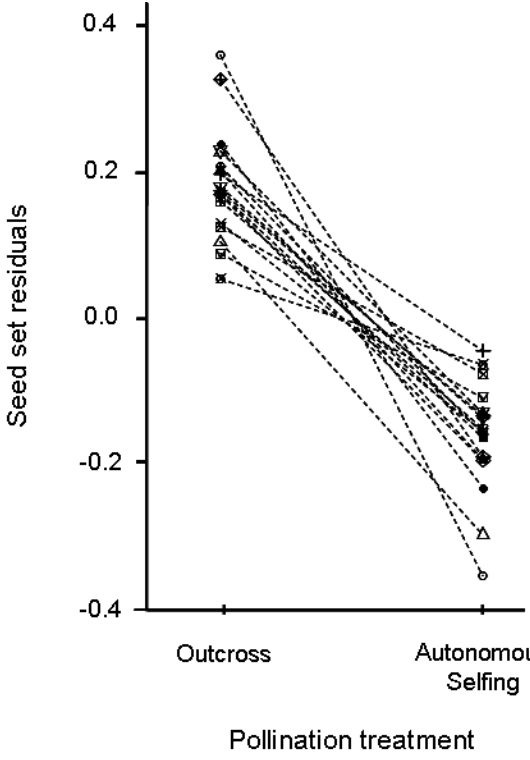
F IGURE 3. Individual plants’ response to cross-pollination and autonomous selfing in Centaurea cyanus